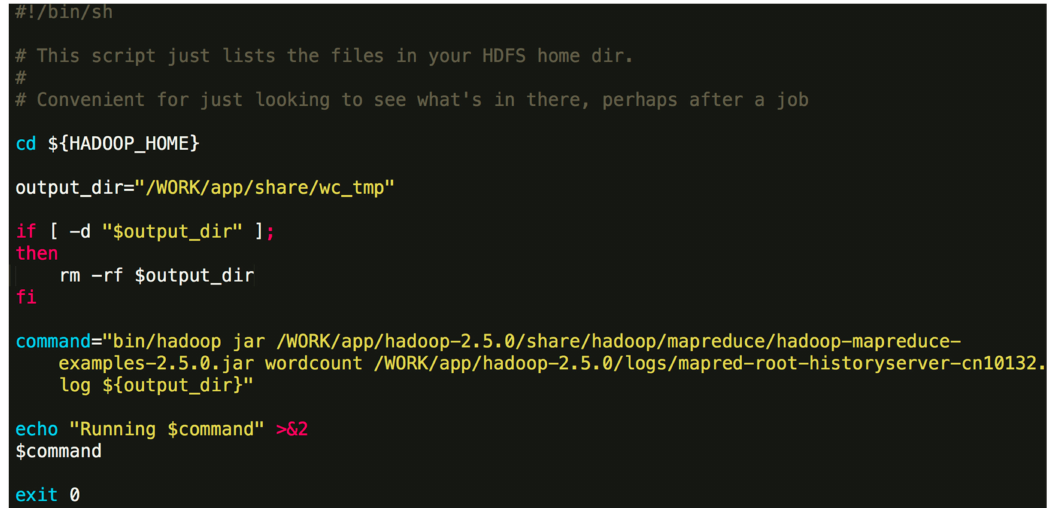
Figure 4. An example job